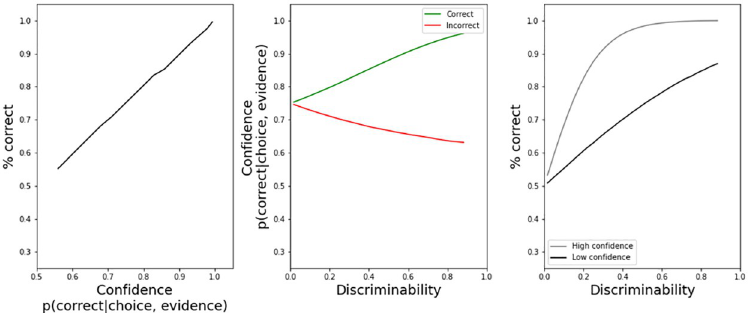
Fig 1. Illustration of confidence properties. Correct answers are more likely with higher confidence (left panel), confidence in correct trials is higher (center panel), and, for a given level of discriminability/difficulty, trials with higher confidence should be more accurate (right panel). This figure was simulated using a uniform distribution for discriminability (U(0,1)) and a normal distribution for the perception of discriminability levels (details in [10]). This figure is not a number comparison model (for that, see Fig 5), just an illustration of the confidence properties proposed by